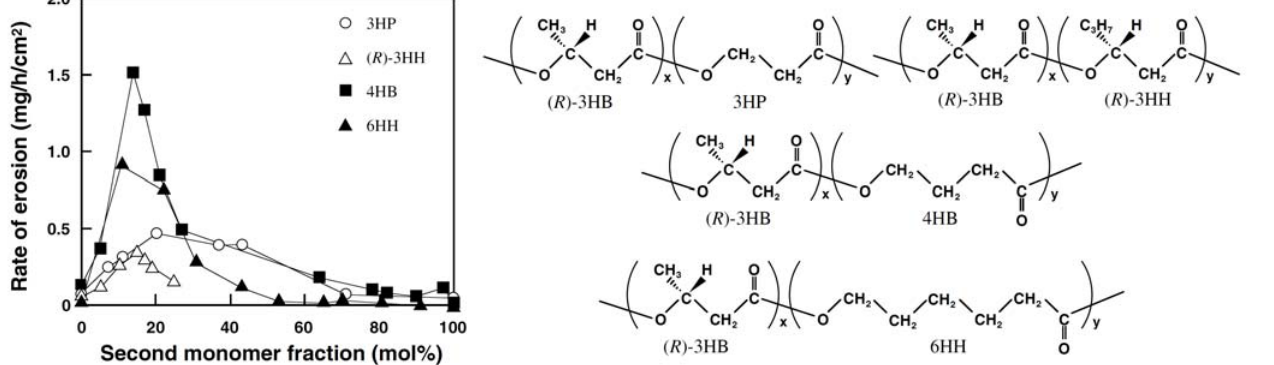
Figure 9. Effects of second monomer units on the rate of enzymatic erosion of solution- cast films of PHA by PHA depolymerase from R . pickettii T1 [43]. Reproduced